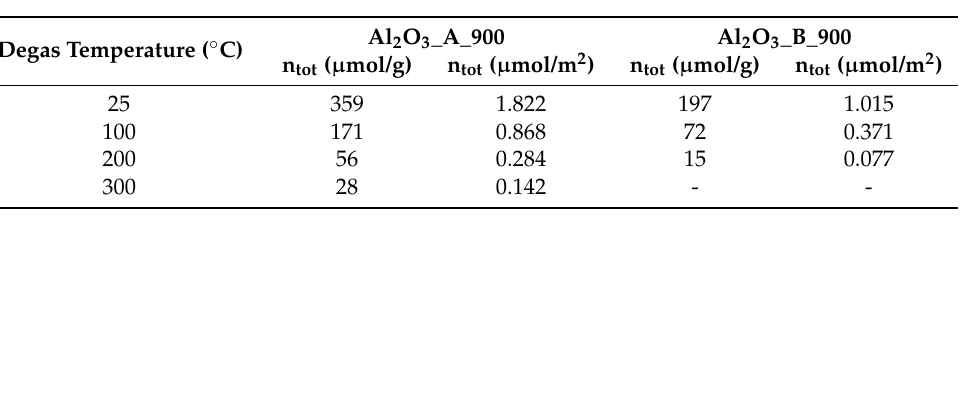
Figure 7. FT-IR spectra of pyridine adsorbed on Al 2 O 3 _A_900 ( a ) and Al 2 O 3 _B_900 ( b ) acquired after degassing at 25, 100, 200, and 300 °C. Table 3. Amount of acid sites determined by FT-IR of adsorbed pyridine for Al 2 O 3 _A_900 and Al 2 O 3 _B_900, after degassing at 25, 100, 200, and 300 °C. Degas Temperature (°C)